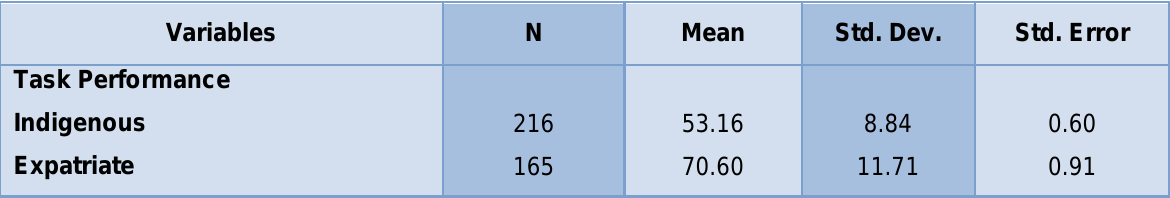
Table 4 Descriptives of independent samples t-test of task performance of construction professionals in indigenous and expatriate construction companies Std. Dev. = Standard Deviation Table 5 indicates Independent Samples t-test of Job Performance of Construction Professionals in Indigenous and Expatriate Construction Companies.